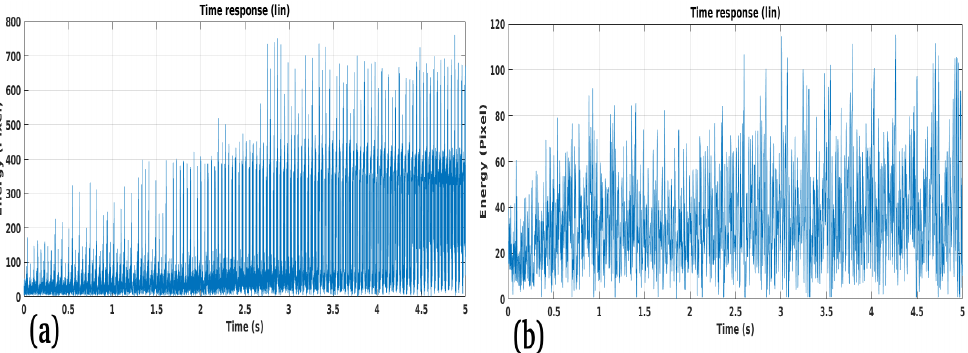
Figure 29. Temporal trend of vibrations: ( a ) point P1, ( b ) point P2.